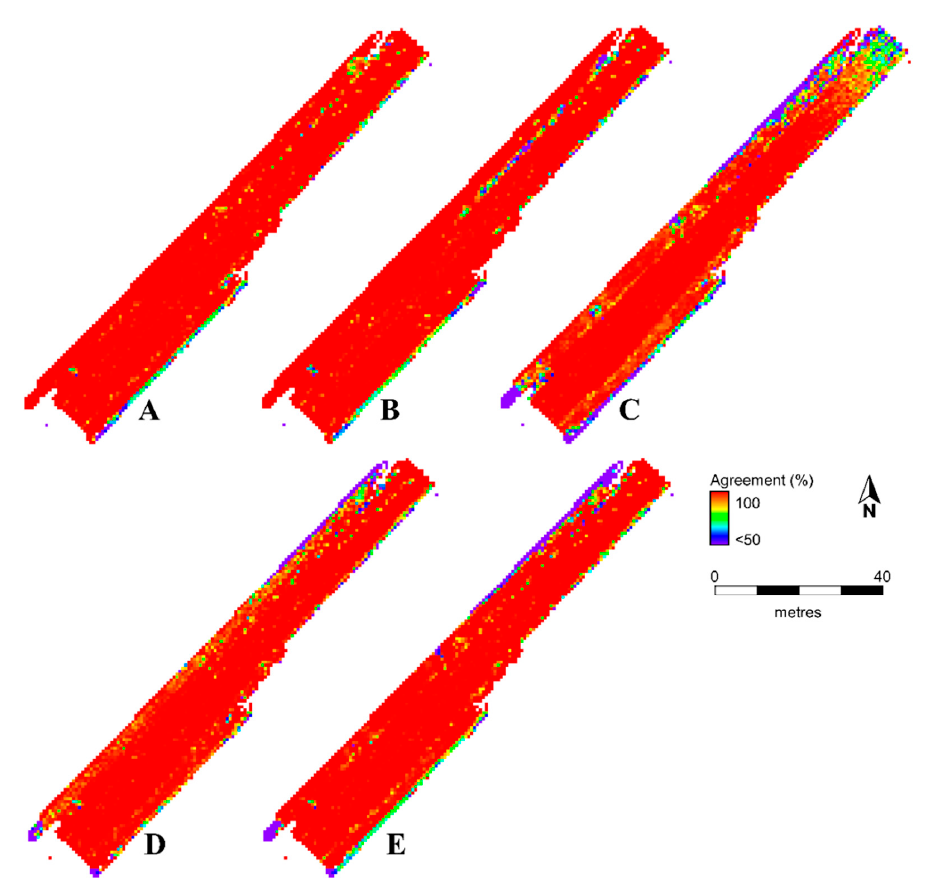
Figure 5. Rasterized classification agreement for the inverted cloth simulation ( A ), hierarchical weighted robust interpolation ( B ), progressive TIN densification ( C ), multi curvature classification ( D ), and modified slope-based filter ( E ) for the road